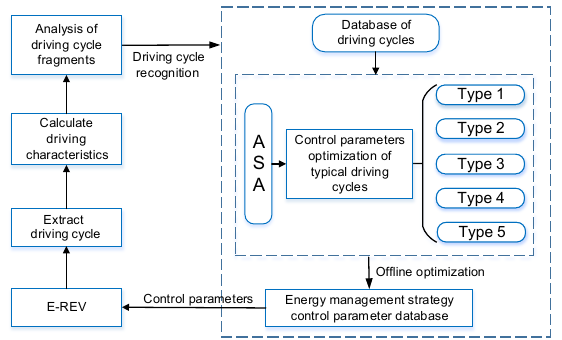
Figure 17. The principle diagram of adaptive multi-workpoints energy management strategy (A-MEMS) based on driving cyle